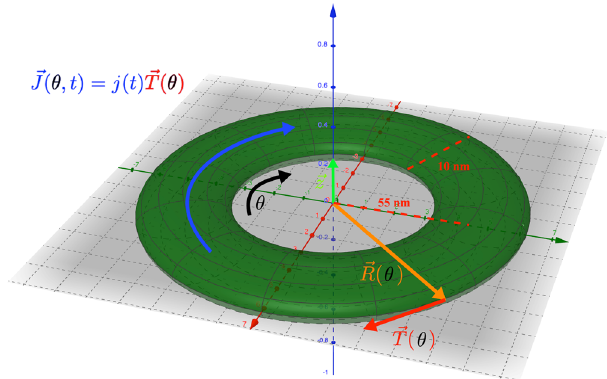
Fig. 1 The geometry of the annulus under study. We consider a nanoscale magnetic device which has the structure of a thick ring, with the dimensions of 10 nm in thickness and 55 nm radius, and vertical dimension of negligible ! ð θ ; t Þ runs along the ring, either size but fi nite. The current con fi guration, J clockwise or anticlockwise depending on the sign of j ( t ). The ring coordinate system is given by ^ T ð θ Þ , ^ R ð θ Þ and ^ z . In the toy model, the thickness of the ring is assumed to be negligible, while in numerical simulations fi nite size effects are